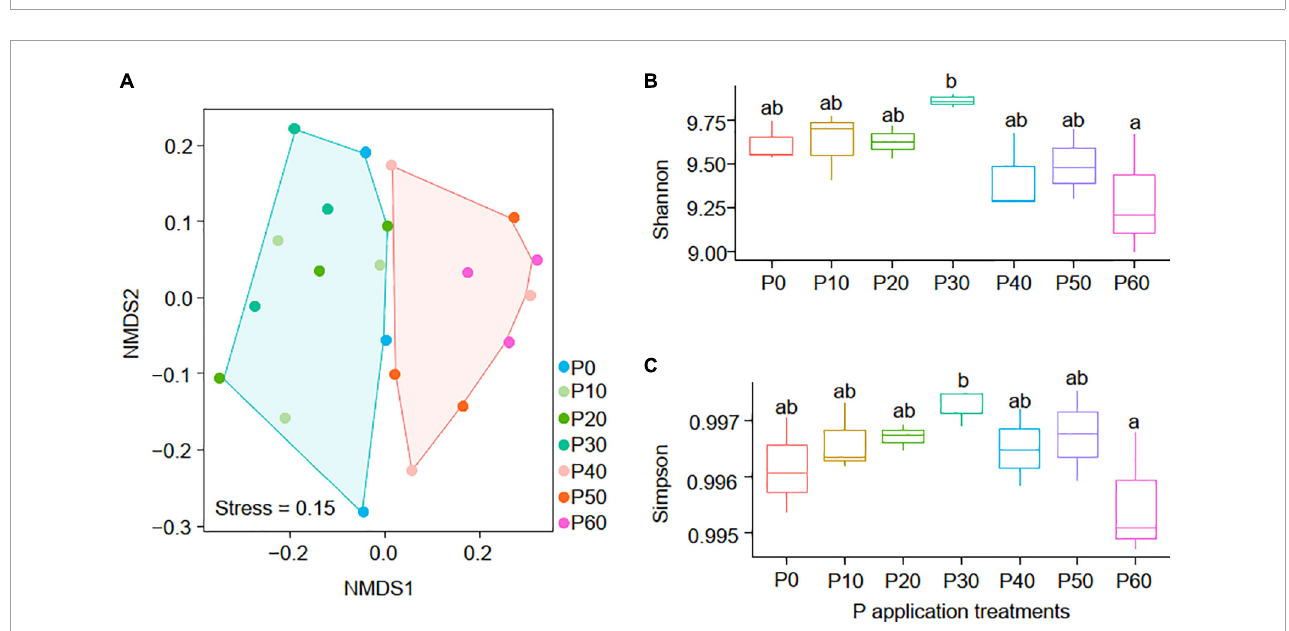
FIGURE3 PhoD-harboring microbial biomarkers revealed by Lefse analysis. (A) Linear discriminant analysis (LDA) cladogram between P application treatments. The circles from inside to outside represent phylum, class, order, family, and genus, respectively. (B) The discriminant phoD-harboring microbial taxa based on relative abundance. The color-coded taxa within the cladogram and histogram indicate significantly enriched taxa in a treatment by Kruskal–Wallis test with P < 0.05 and logarithmic LDA > 2.0 ( n = 3 for each group).